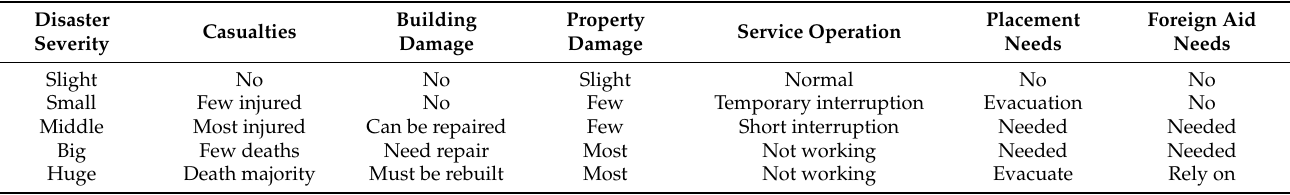
Table 3. Fire hazard severity statement table.